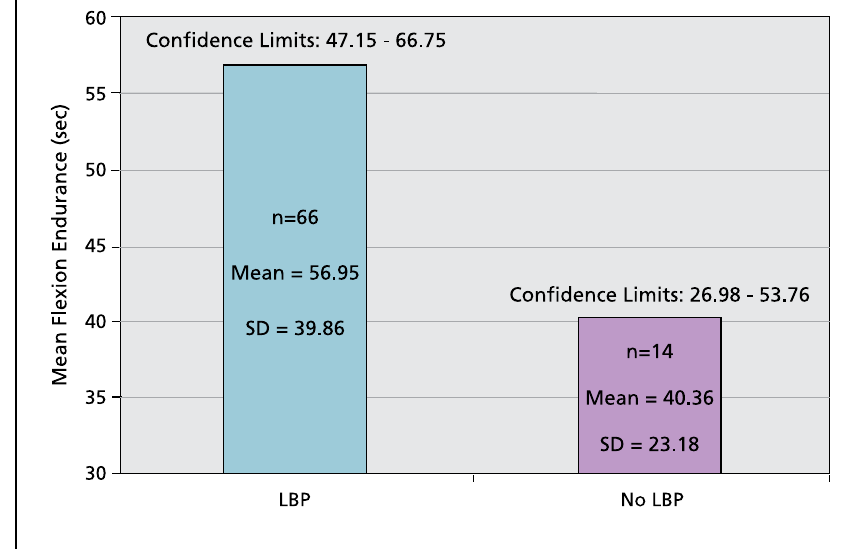
Figure 1: Mean values for trunk flexor muscle endurance